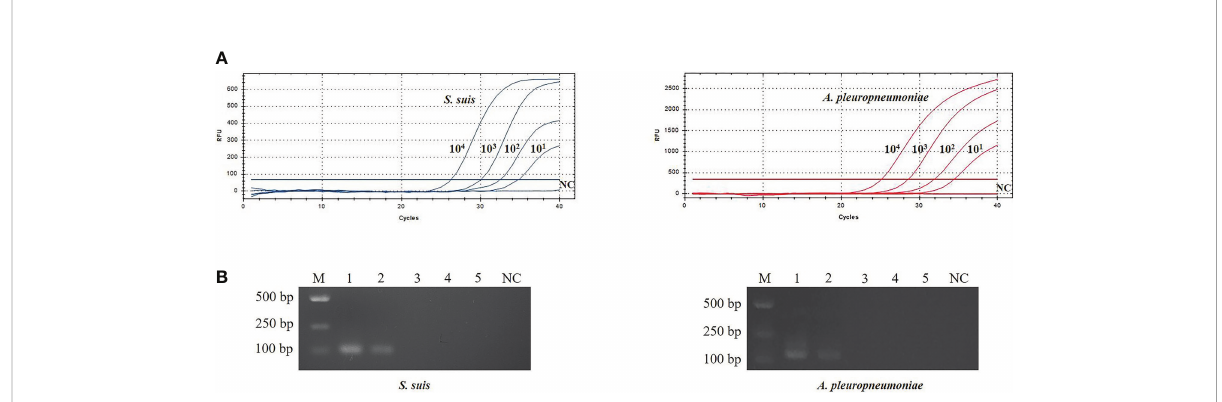
FIGURE 3 Evaluation of sensitivity for TaqMan real-time PCR (A) and conventional PCR (B) .The plasmid template dilution concentrations of S. suis and A. pleuropneumoniae were 7.534×10 4 ~7.534×10 0 copies/ m L and 6.555×10 4 ~6.555×10 0 copies/ m L, respectively. M: DL2000 Marker; B1-5: 10 4 copies/ m L-10 0 copies/ m L plasmid standards; NC, Negative control.